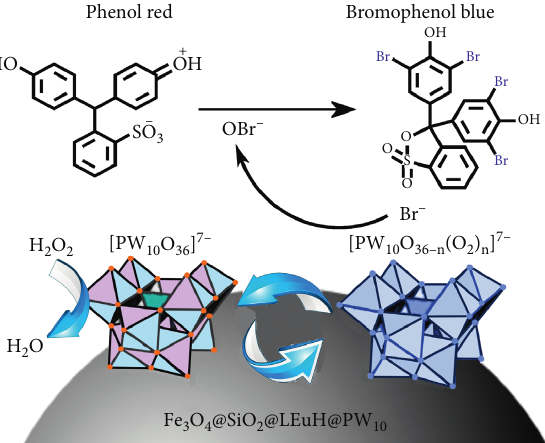
Figure 24: The proposed mechanism of reaction for the bromination of phenol red to bromophenol blue using Fe as a catalyst.